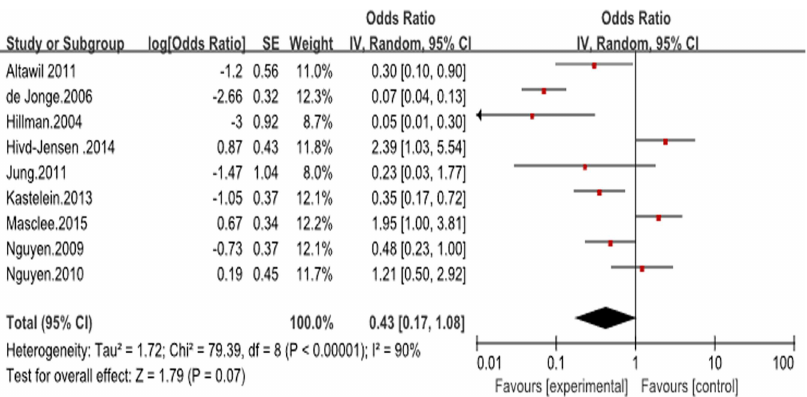
Fig 2. Forest plot of assessing the effectsof PPIs on the patients with Barrett’sesophagus (BE) and the risk of esophageal adenocarcinoma (EAC) and/or high-grade dysplasia (HGD) in all included